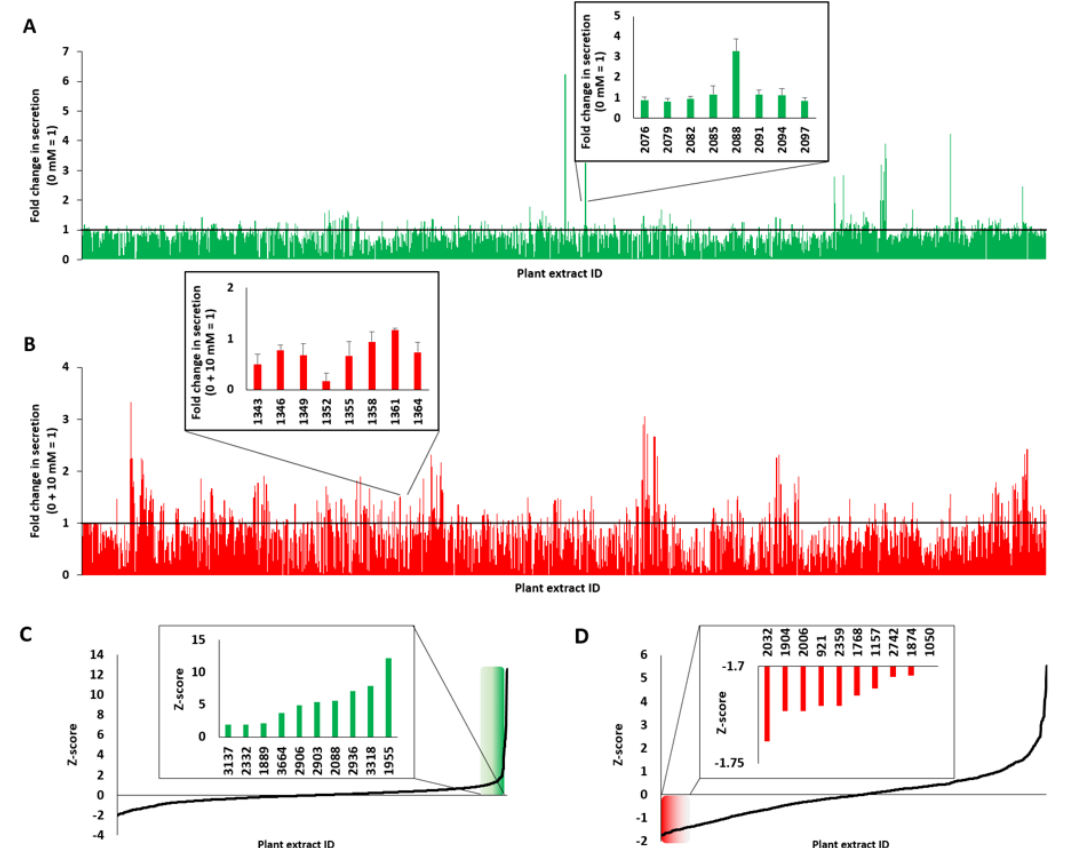
Figure 3. Ins-Gluc-expressing MIN6 β cells were treated with more than 1100 plant extracts ( A ), green illustrated data or preincubated with these extracts and diazoxide (DZ) for 1 h and stimulated with 10 mM glucose ( B ), red illustrated data. The Z-score was calculated from normalized values, and the data were sorted and are illustrated in ( C ) for incubation with plant extracts and ( D ) for incubation with plant extracts in combination with 10 mM glucose. Plant extracts were screened at a final concentration of 10 µg/mL ( n = 4).